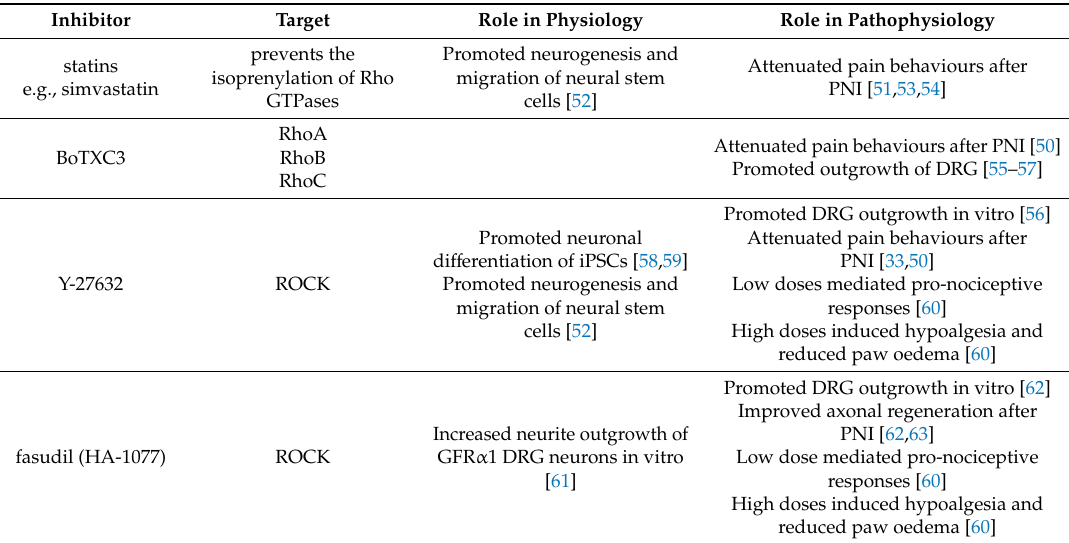
Table 2. The most commonly used inhibitors of Rho GTPases and downstream partners used in studies on peripheral sensory